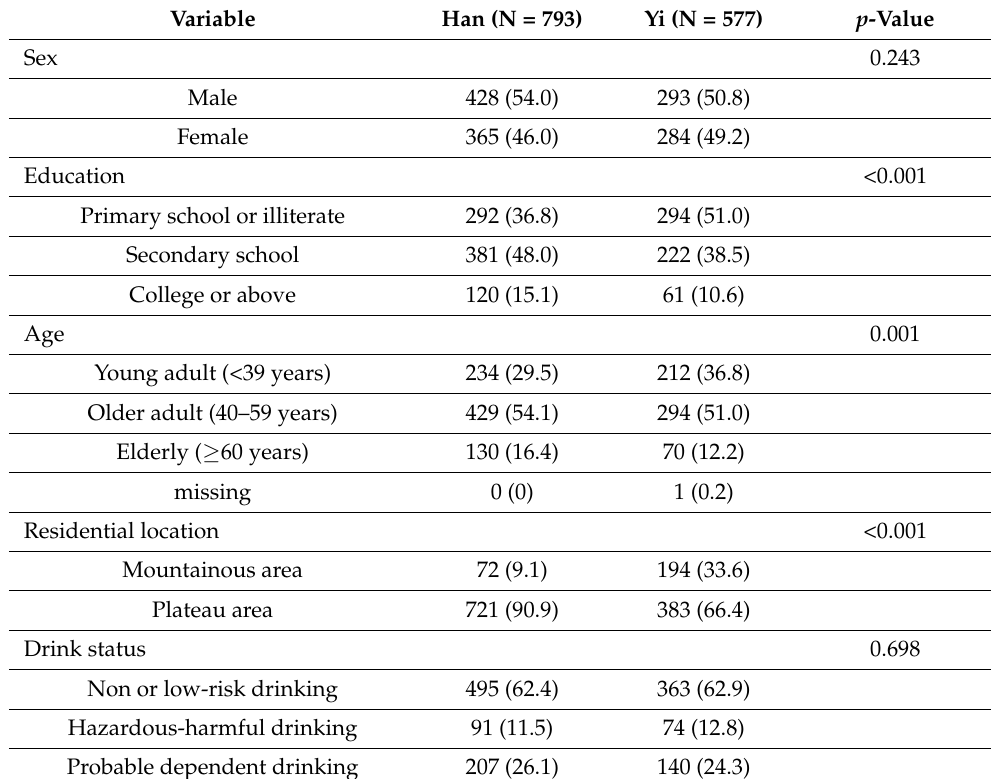
Table 2. Participant socio-demographic characteristics and drinking status, in frequencies and percentages.